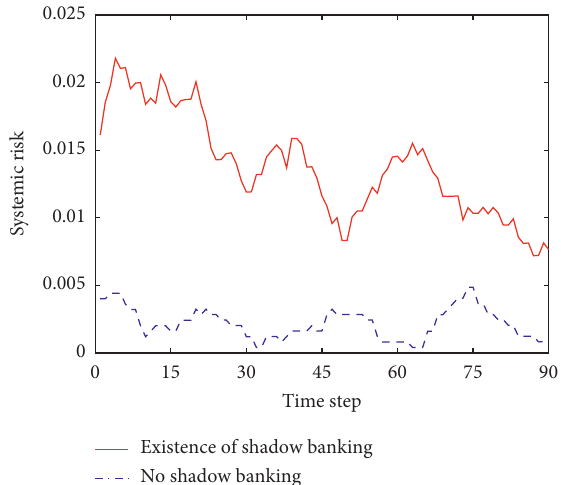
Figure 3: The impact of the existence of shadow banking on the systemic risk (the parameters are set as follows: r � 0.0035, r � 0.023, β � 0.15, χ � 0.3, σ � 0.3, σ � 0.03, c � 0.03, a b A ω A � 1000, ω � I � 500, ρ � 0.045, τ � 3, d � 3, R s 1 � 0.07, R s 2 � 0.03, o o R s 3 � 0.01, p � 0.95, p � 0.5, p � 0.3, U � 400, M � 400, and N � 0 o 1 2 3 for the case of no shadow banking and M � 100 and N � 300 for the case of existence of shadow